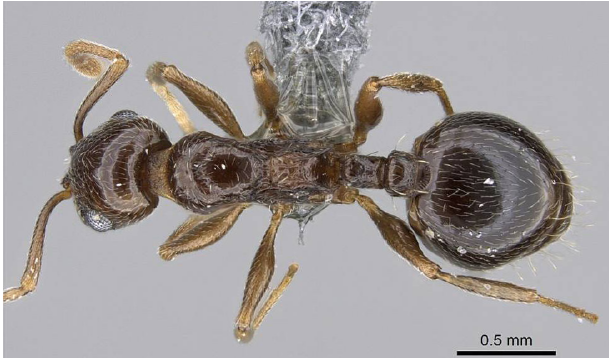
Fig 3 . Temnothorax ansei sp.n. worker in dorsal view. Photo credit: